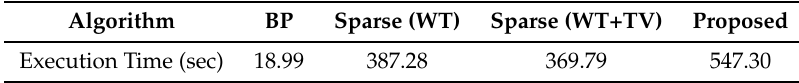
Table 2. Execution time for different reconstruction algorithms with 120 view